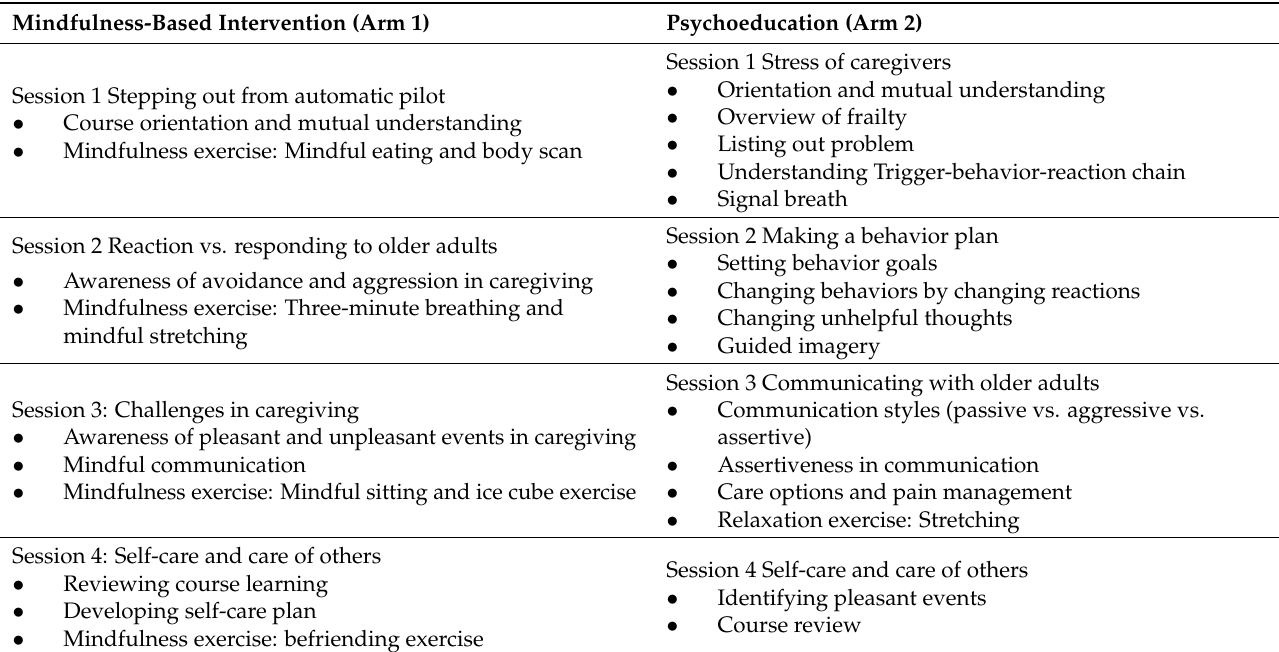
Table 1. Content of mindfulness-based intervention (Arm 1) and psychoeducation (Arm